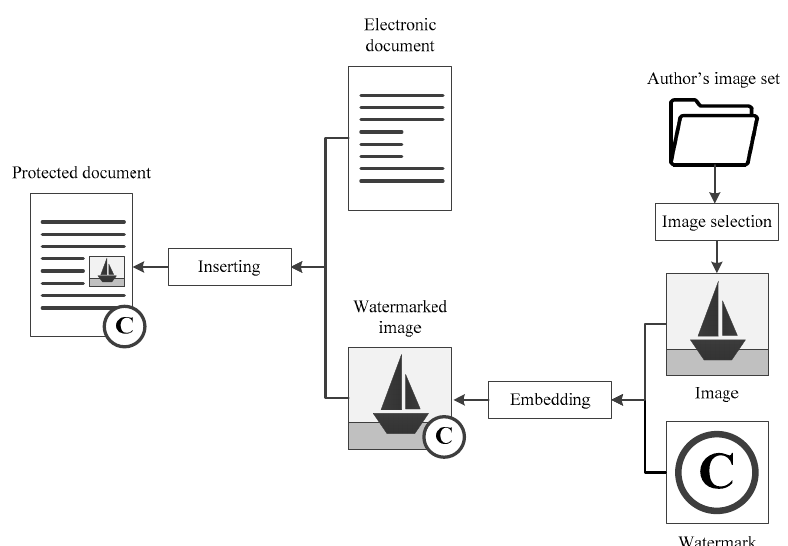
Figure 1. General scheme of document protection according to the proposed technology.